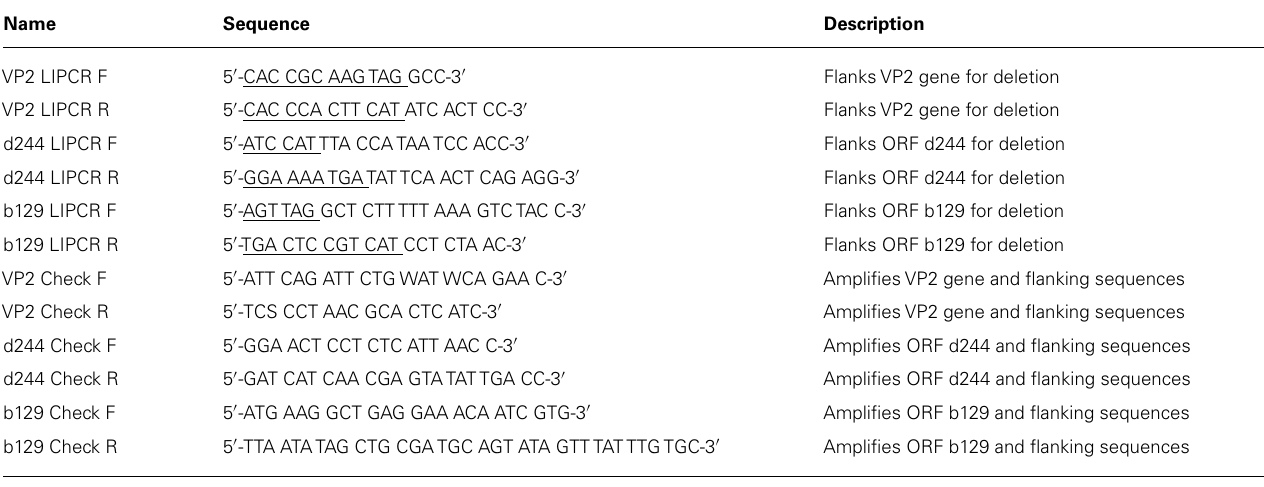
Table 2 | Oligonucleotides used in this work.